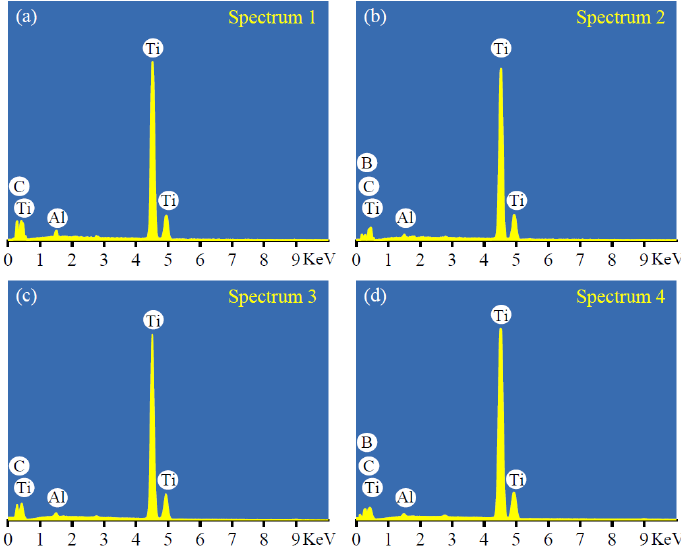
Figure 8. EDS spot scanning energy spectrum analysis results: ( a ) Spectrum 1 in Figure 7a, ( b ) Spec- trum 2 in Figure 7a, ( c ) Spectrum 3 in Figure 7d, ( d ) Spectrum 4 in Figure 7d. Table 2. EDS spot scanning energy spectrum analysis results (Atomic%).